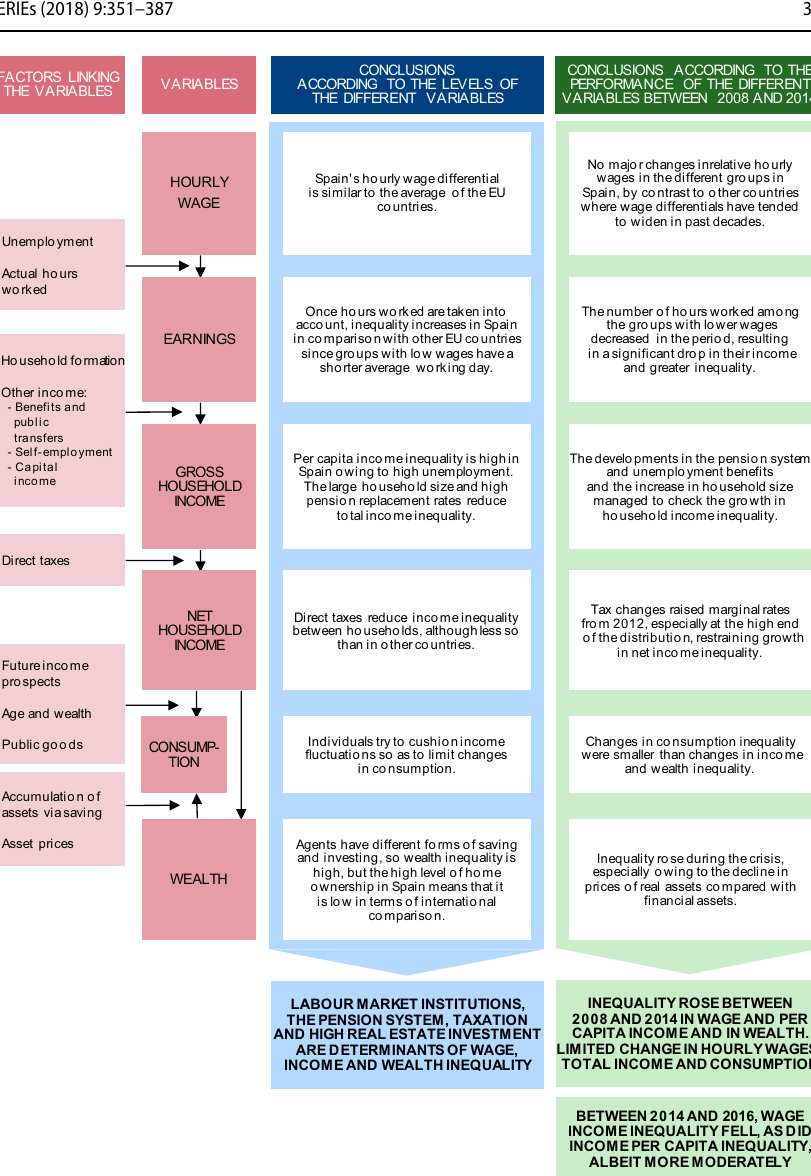
Appendix 2 See Table